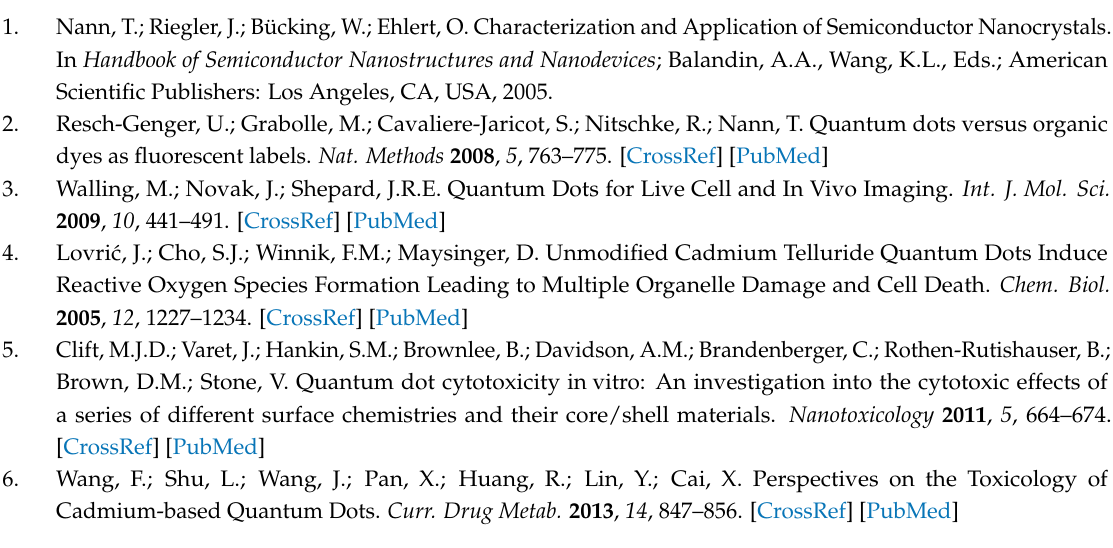
Figure S1: Positive and negative controls of ROS; Figure S2: Representation of TNF α secretion on RAW 264.7 cells vs concentration, after treatments with QDs with ligands Oligo, PEG-NH 2 and MSA are available free of charge via the Internet at